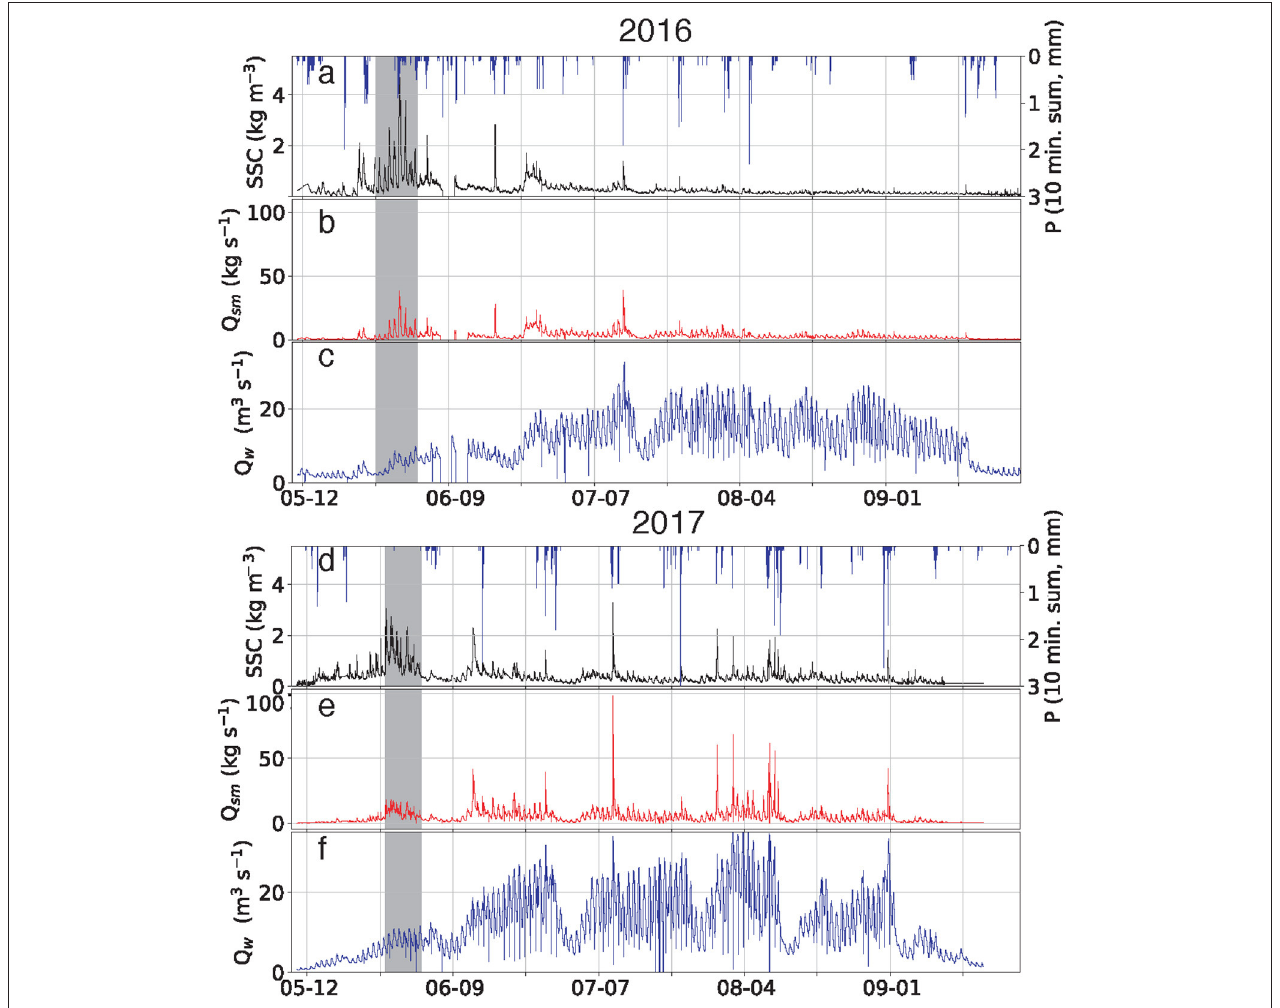
FIGURE 4 | Time series of the Gornergletscher catchment data over the 2016 and 2017 seasons. (a,d) Suspended sediment concentration (SSC), blue bars represent precipitation (P). (b,e) Sediment discharge (Q s ). (c,f) Water discharge (Q w ). Gray bars indicate the periods of the ice-marginal lake